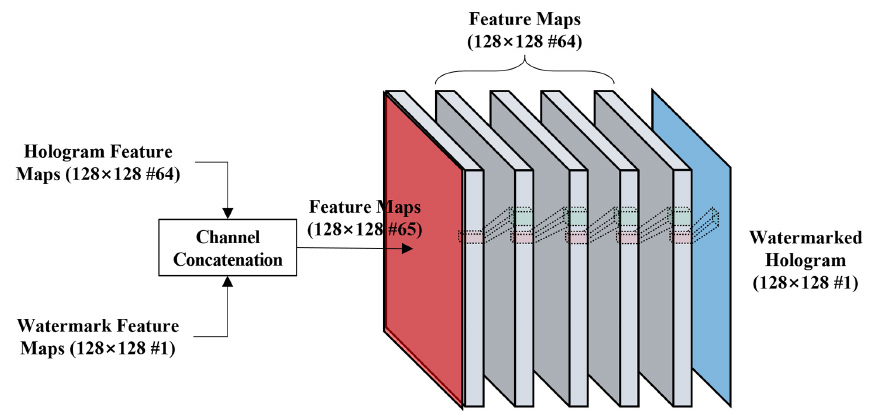
Figure 3. Network structure of the watermark-embedding network (WMN).